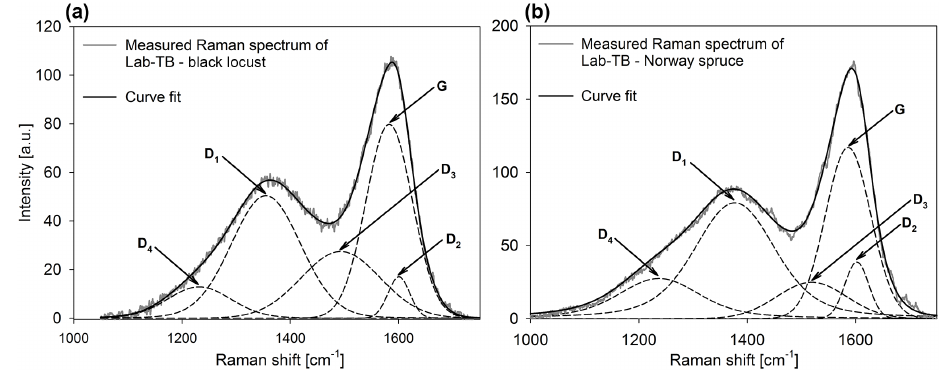
Figure 3. Curve fit with five bands for the first-order Raman spectra (excitation wavelength: λ 0 = 532nm) of laboratory-generated tar ball (Lab-TB) particles, produced from (a) black locust and (b) Norway spruce, using as proposed by Catelani et al. (2014) for carbonaceous